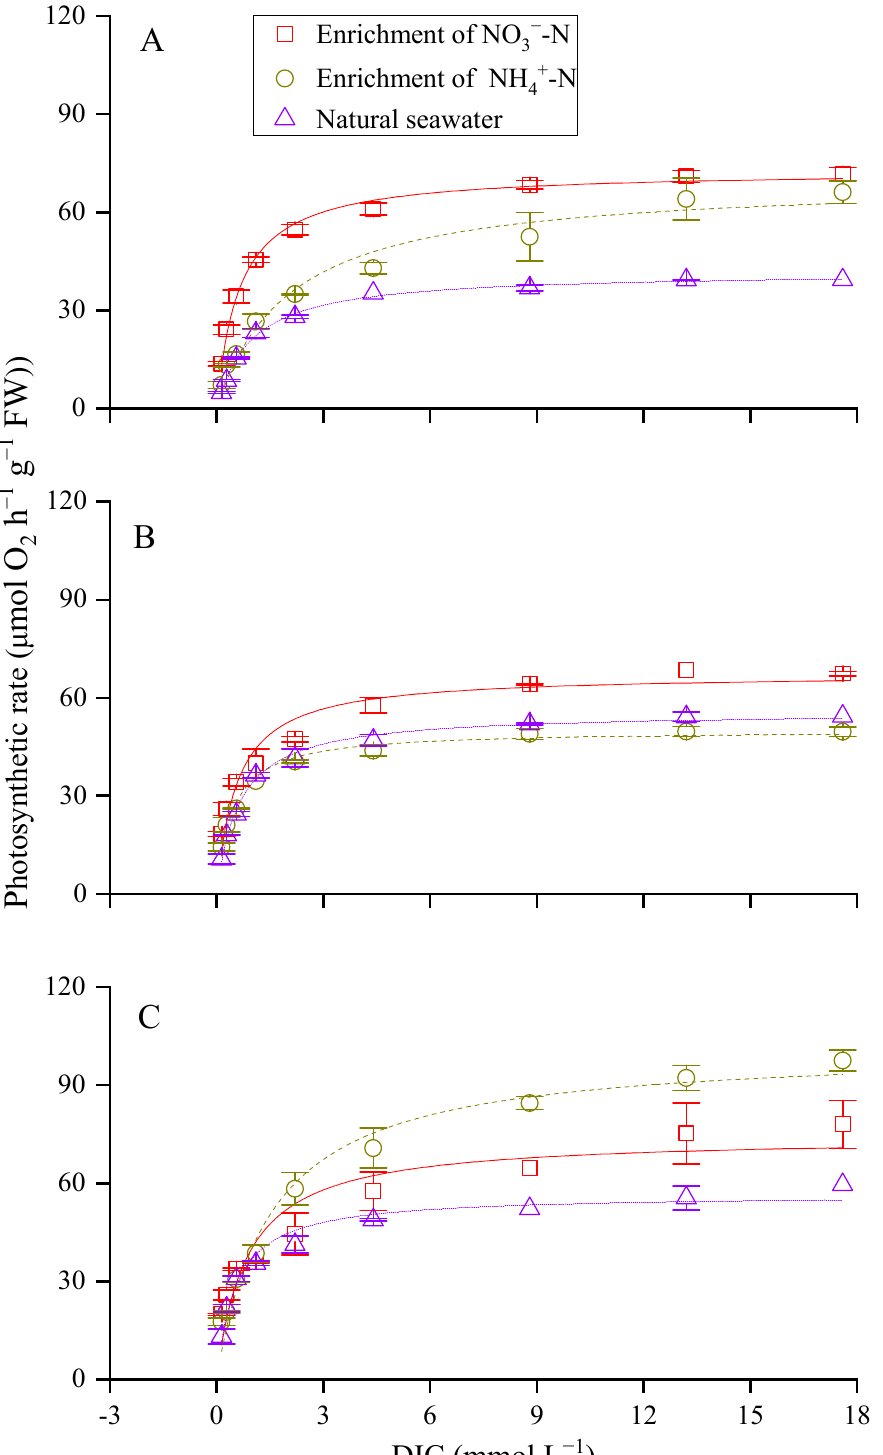
Figure 2. Photosynthesis versus DIC curves of S. horneri after being cultured under different light and N conditions for 10 days ( A , Low-light; B , Middle-light; C , High-light). Data are reported as means ± SD (n = 3). DIC is dissolved inorganic